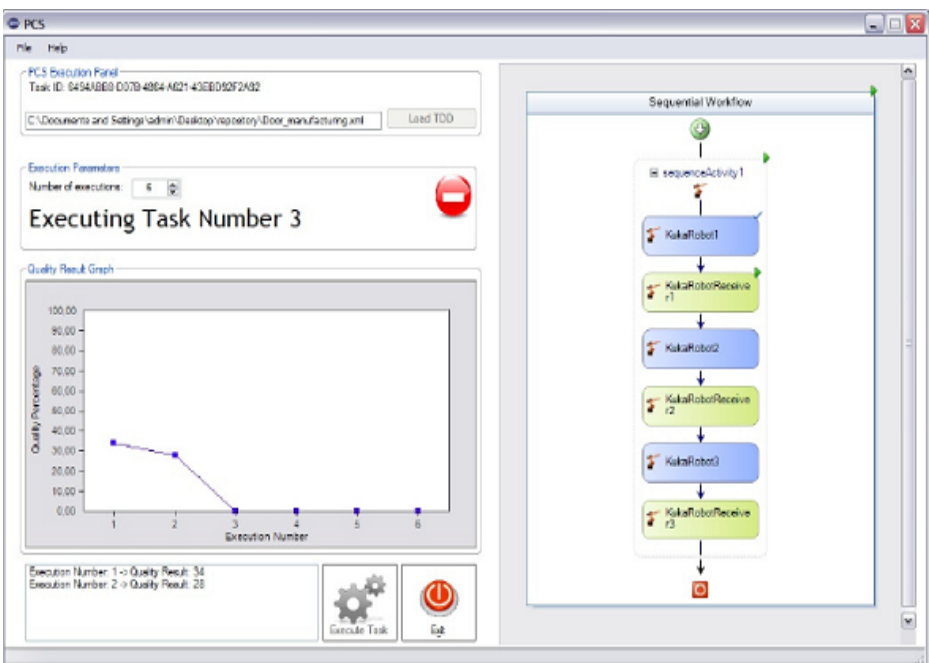
Figure 7. PCS GUI